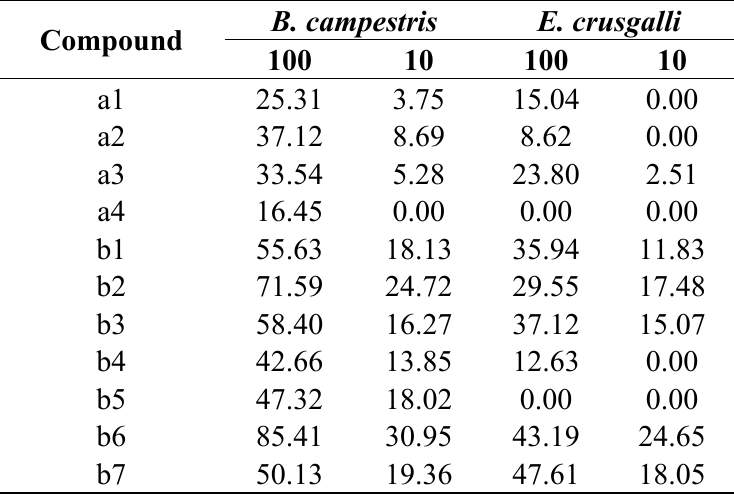
Table 1. Herbicidal activity of compounds (% I; concentration, μ